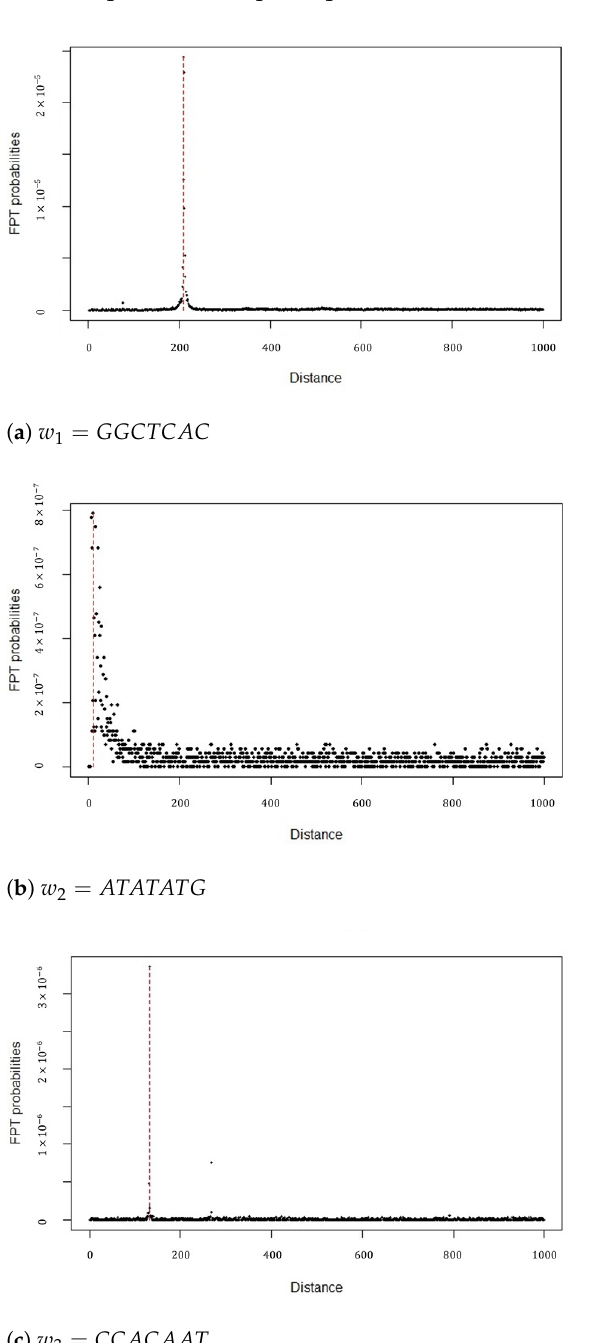
Figure 1. First passage time (FPT) probabilities for distance n ≤